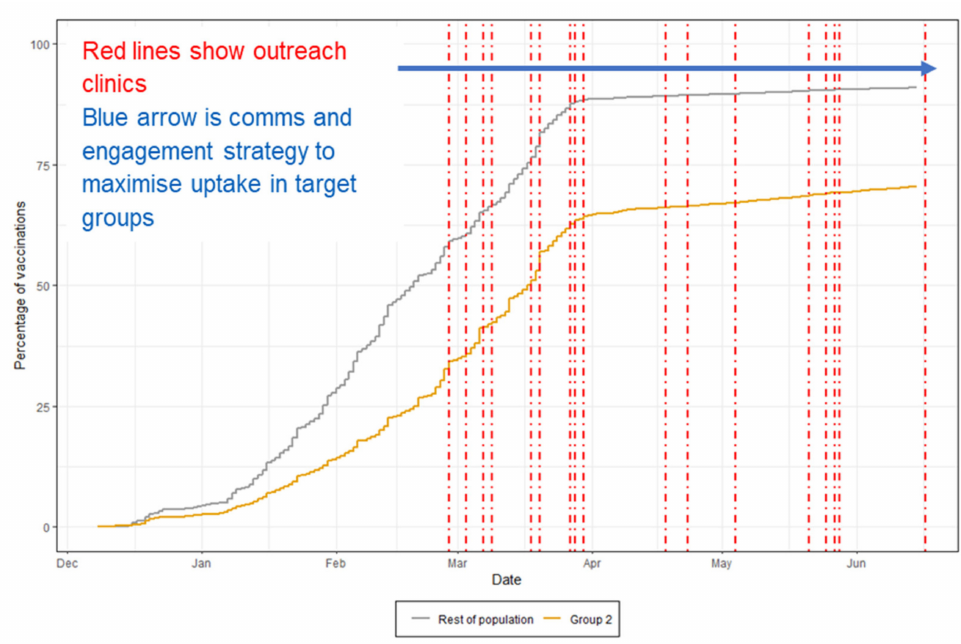
Figure 2. Percentage of population vaccinated (first doses) for Group 2 vs. the rest of the BNSSG population. The red dotted lines represent some of the outreach